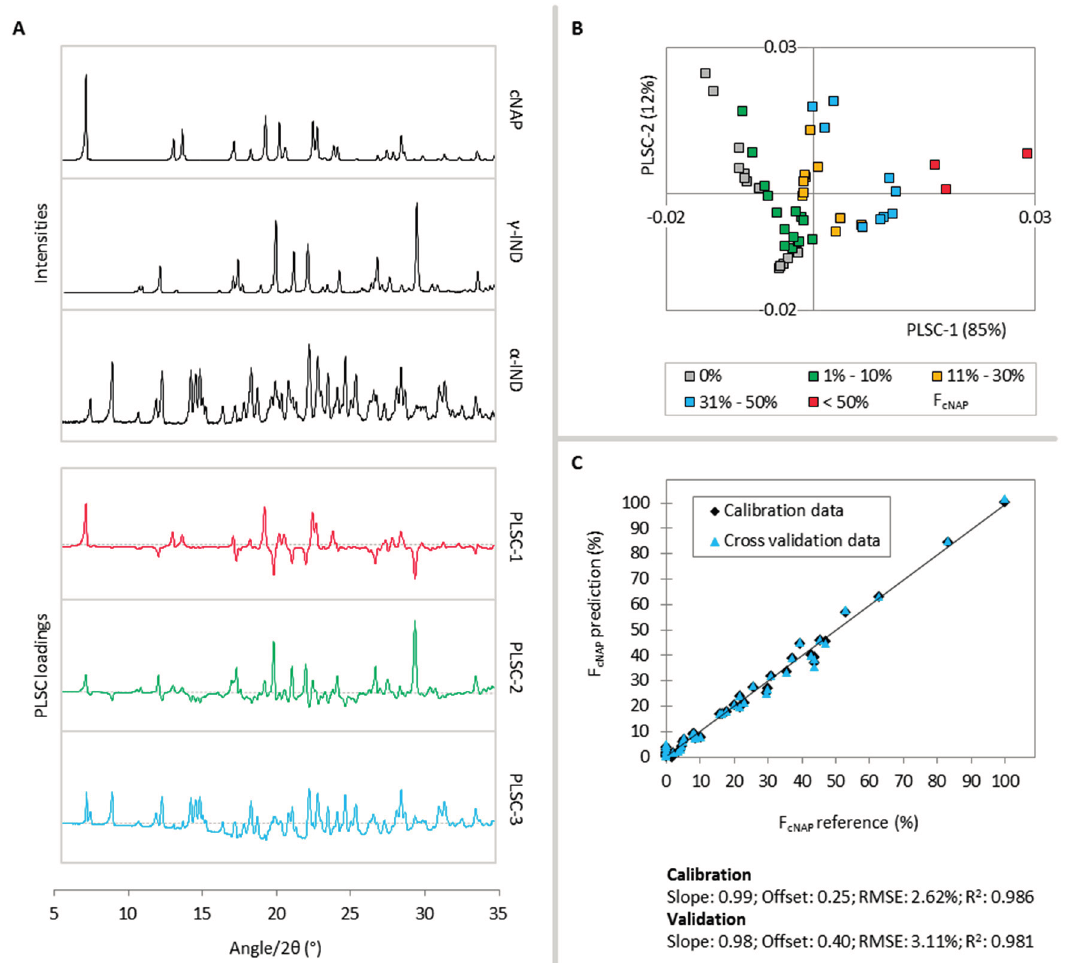
Figure 2. ( A ) Reference diffractograms of cNAP, γ -IND, α -IND (black lines) and PLSC-1 (red), PLSC-2 (green) and PLSC-3 (blue) loadings plots for the F cNAP PLS model,; ( B ) PLSC-1- vs. -PLSC-2 scores plot, the different colors classify the calibration samples according to their cNAP fractions; ( C ) Correlation of the PLS predicted cNAP fractions vs. the reference values during the calibration (black diamonds) and cross validation (blue